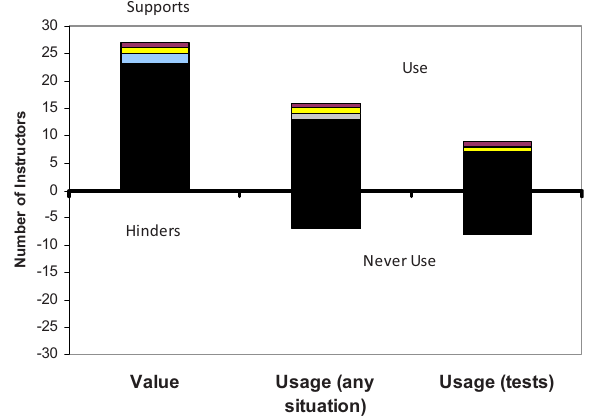
FIG. 4. (cid:1) Color (cid:2) Value and usage of problem features related to the learning goal of developing students’ physics understanding. The legend is in Fig. 3.